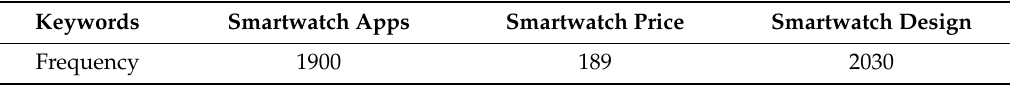
Table 1. Example of keywords extraction from Facebook .